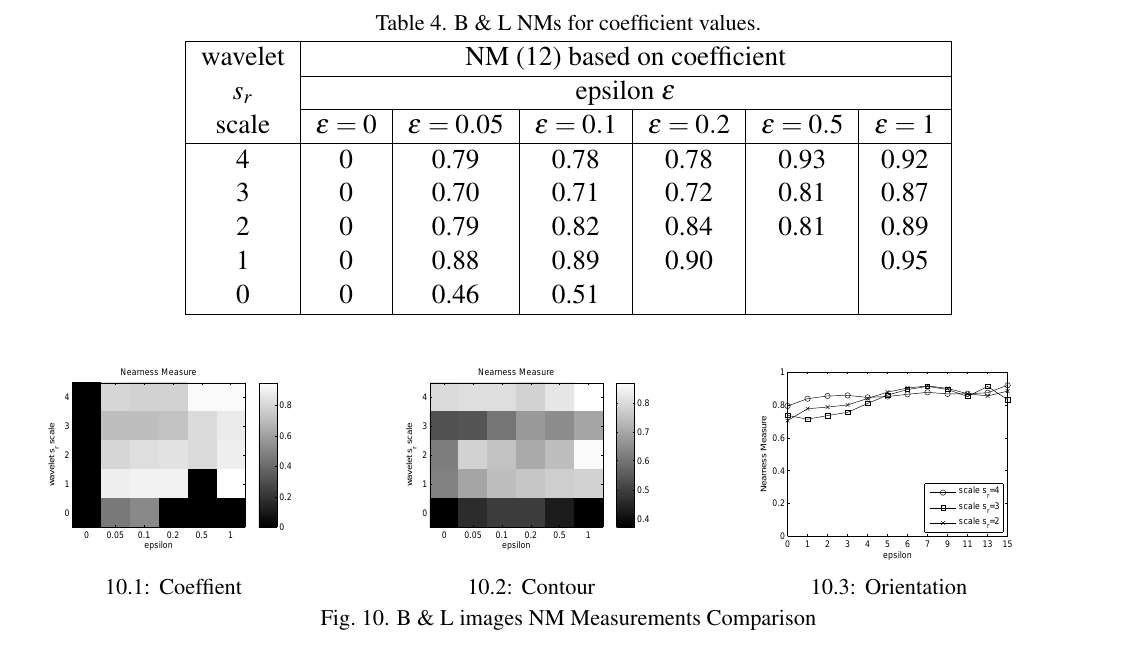
Table 4. B & L NMs for coefficient values.